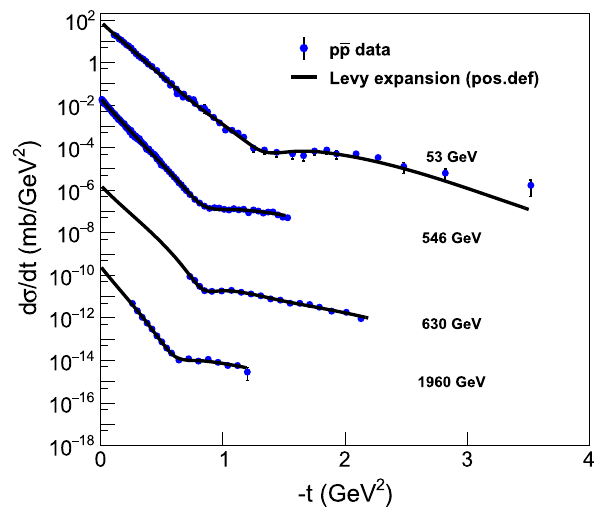
Fig. 5 Summary plot of the model-independent Lévy expansion fits to the elastic p ¯ p scattering data at ISR, S p ¯ p S, and Tevatron energies √ s = 23 . 4 GeV up to 1 . 96 TeV. The fits converged, ranging from